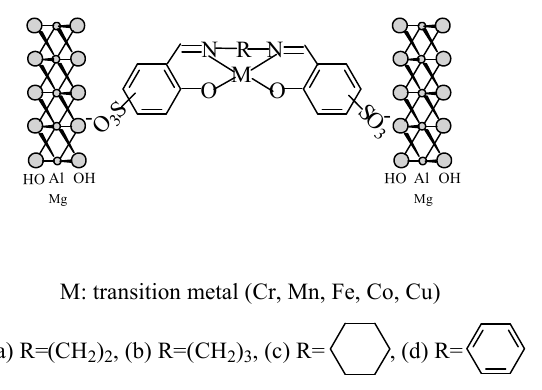
Scheme 1. Structure schematic diagram of LDH (layered ‐ double hydroxides) ‐ hosted complexes: ( a )